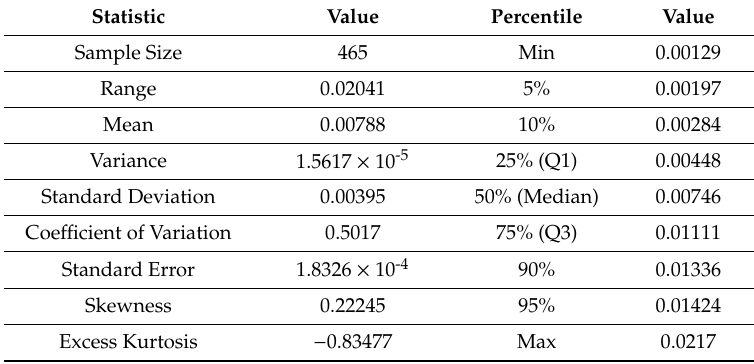
Table 2. The descriptive statistics of the empirical data for T cl = 4